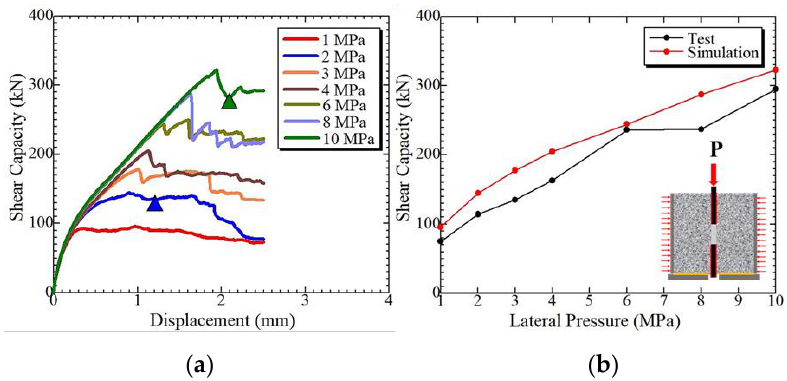
Figure 8. Influence of lateral pressures on the shear capacity of PBL: ( a ) Analytical load–displacement relations; ( b ) Comparison of test and analytical shear capacities.